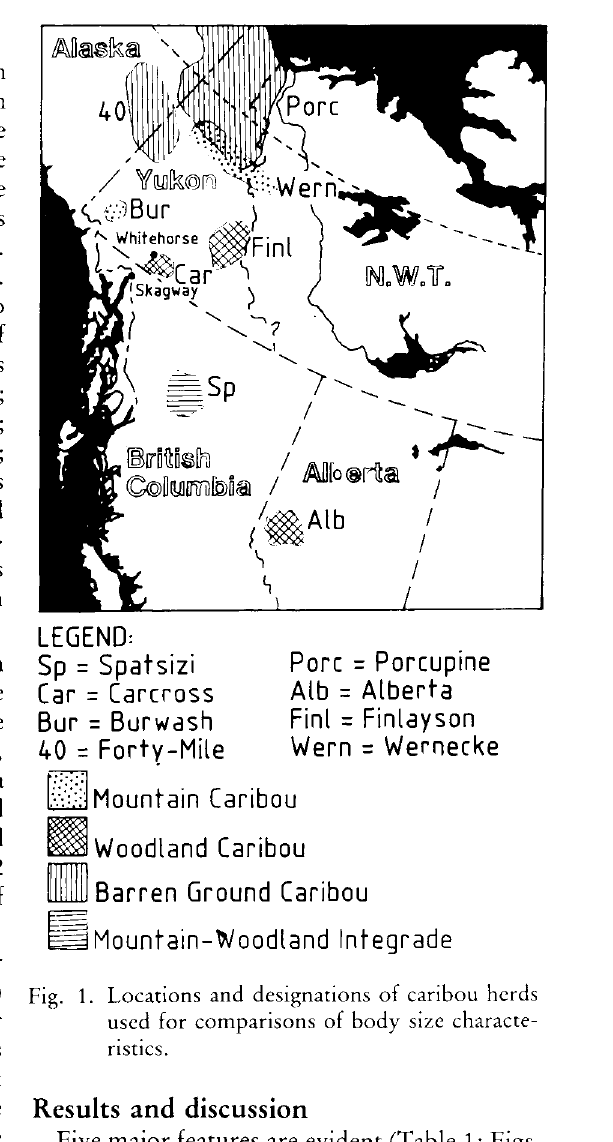
Fig. 1. Locations and designations of caribou herds used for comparisons of body size characte